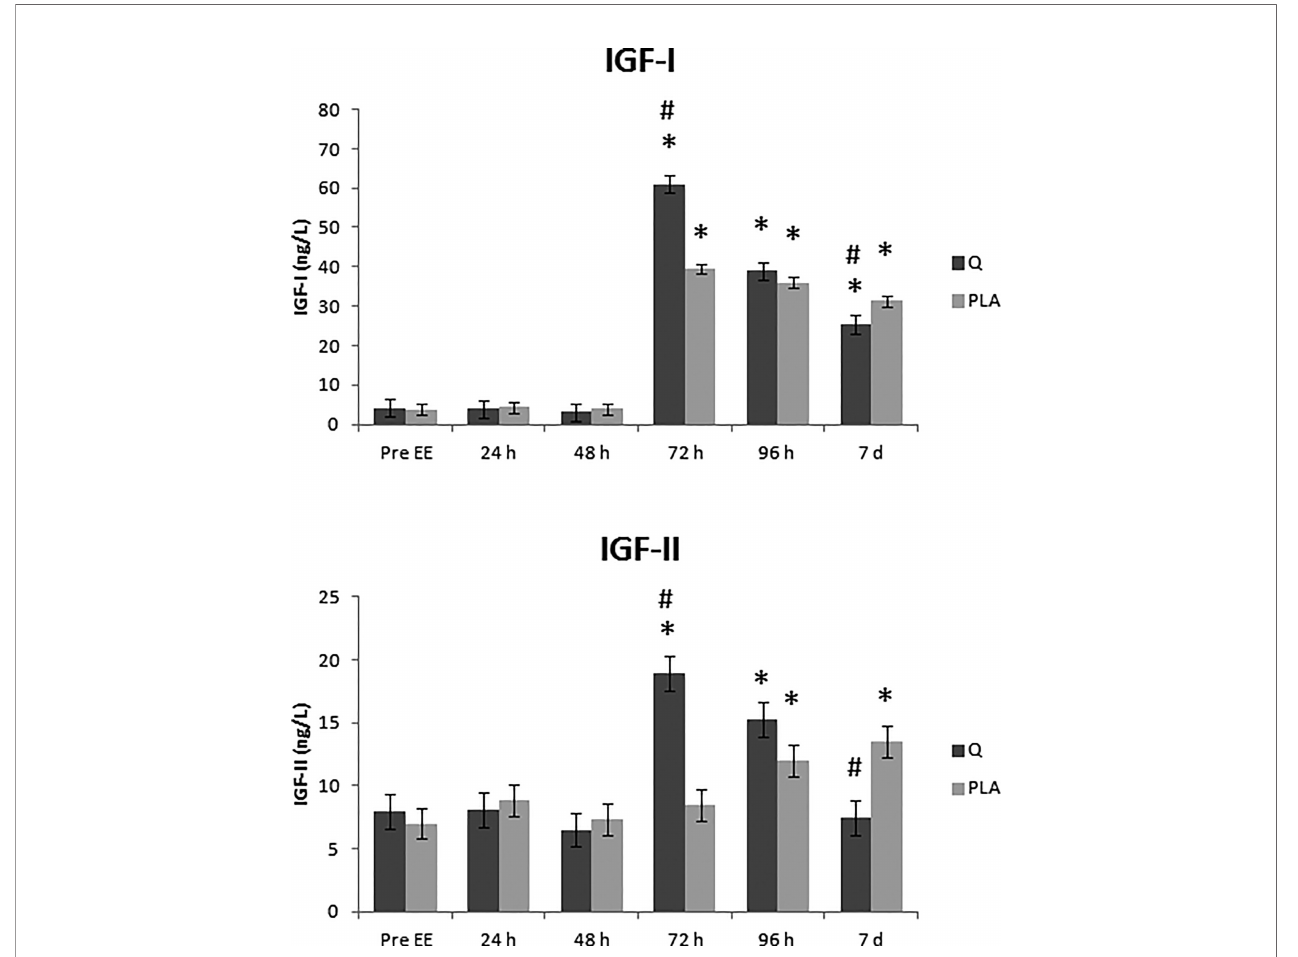
FIGURE 3 | Effect of quercetin supplementation on insulin-like growth factor 1 (IGF-I) and insulin-like growth factor 2 (IGF-II) plasma levels. The levels of insulin-like growth factor 1 (IGF-I) and insulin-like growth factor 2 (IGF-II) were measured in plasma of quercetin/placebo supplemented subjects before the eccentric exercise (Pre EE) and after 24, 48, 72 and 96 hours (24 h – 96 h) and after 7 days (7 d) recovery time. Values are expressed as means ± pooled SEM. n =12 for each group. *P < 0.05 vs Pre EE and # P < 0.05 vs